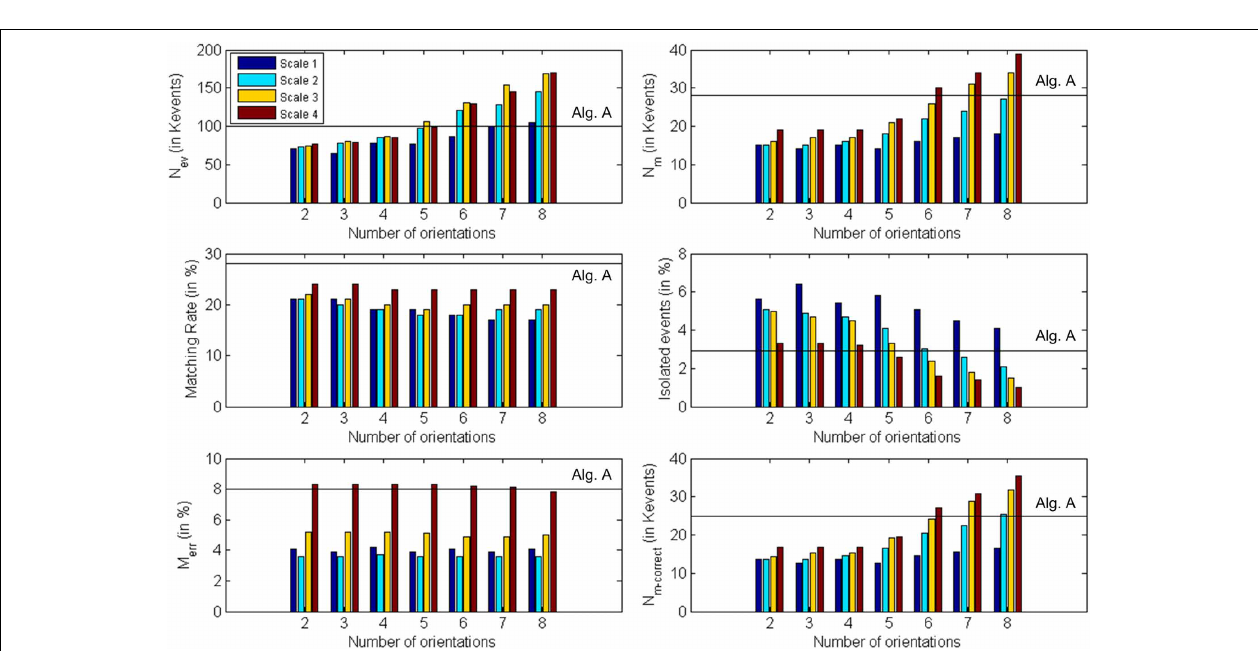
FIGURE 15 | Graphical representation of Table 1. Each subplot corresponds to a different row of the table, showing the obtained values for each number of orientations and scale. The black horizontal lines indicate the values obtained using algorithm A (0 orientations).